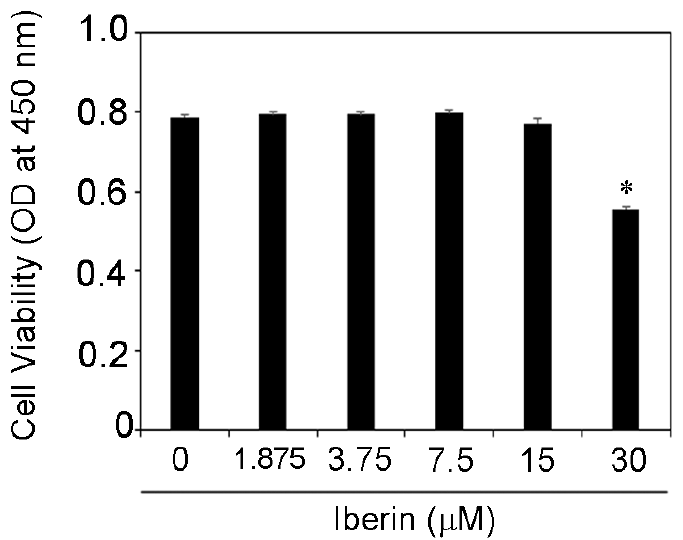
Figure 1. Effects of iberin on cell viability of TR146 cells. TR146 cells were seeded on 96-well cell culture plates, grown for two days, and then treated for 24 h with iberin (1.875–30 µ M). The vitality of cells was determined using Cell Count Reagent SF. The data are presented as the mean SD of four independent experiments. * = p < 0.05, significantly different from TR146 cells not treated with iberin.